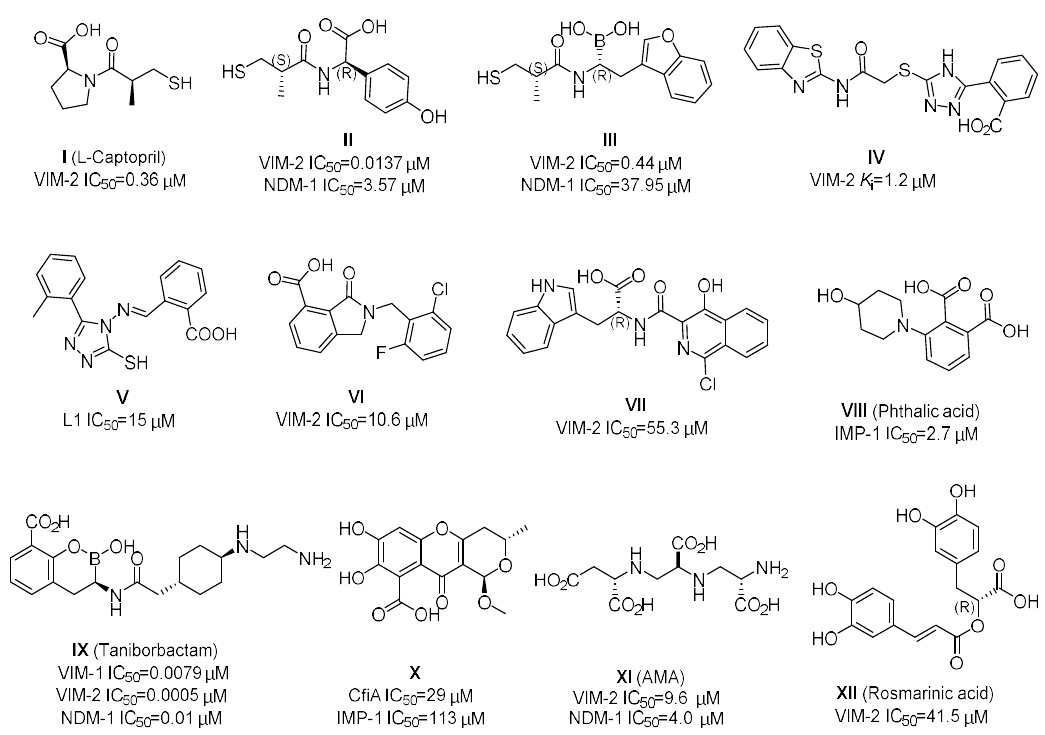
Figure 1. Chemical structures and inhibition potencies of some reported metallo- β -lactamase (MBL) inhibitors.